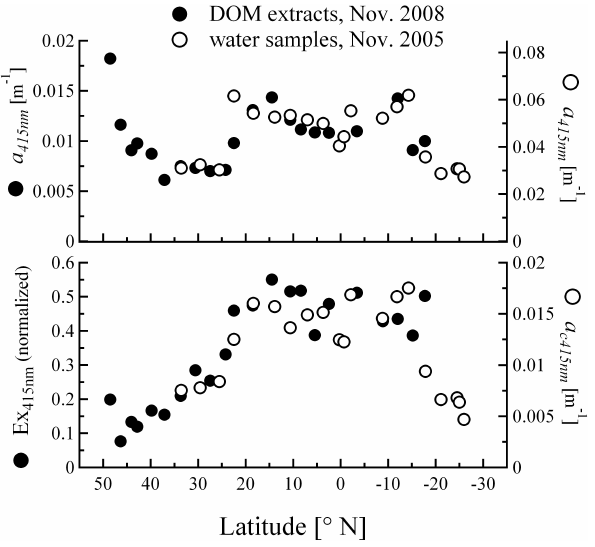
Fig. 4. Latitudinal distribution of the CDOM absorption at 415nm in the eastern Atlantic Ocean, a 415 nm (upper panel); and 415-nm chromophore absorption, a c 415 nm , and normalized fluorescence excitation, Ex 415 nm (both lower panel). Measurements of a 415 nm and a c 415 nm were done in November 2005 during ANT-XXIII/1 directly on water samples (open symbols) and those for a 415 nm and Ex 415 nm in November 2008 during ANT-XXV/1 on DOM extracts (closed symbols). Note the differences in axis scale of the upper panel, probably due to incomplete sampling and extraction the absolute absorption determined from the extract is lower by a factor of four.